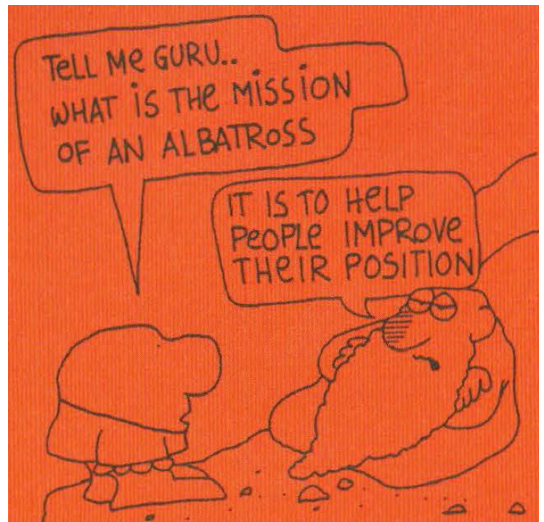
Figure 6: Excerpt from a small leaflet explaining the “Theory Albatross” culture, inspired by the comic figure “Ziggy” by Tom Wilson. Illus- tration: